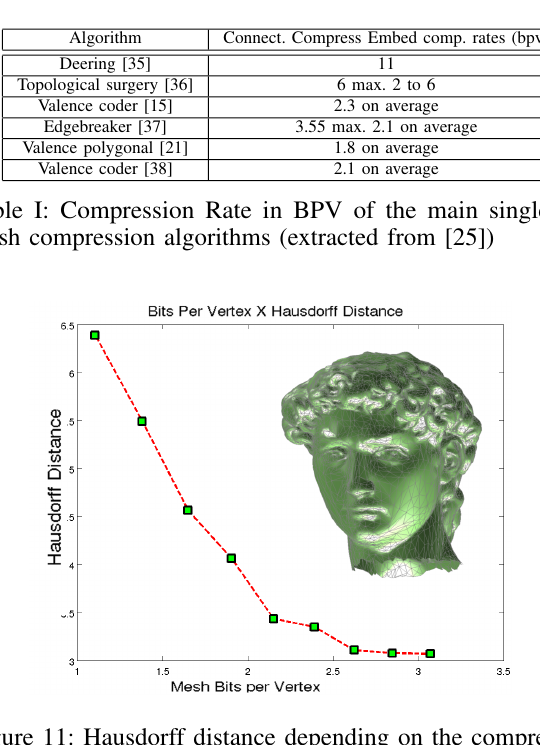
Figure 11: Hausdorff distance depending on the compression rate (BPV) to the David’s Head model